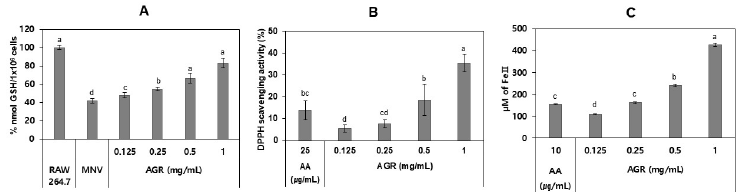
Figure 4. Antioxidant activities of AGR extract. ( A ) GHS levels in MNV-infected cells, ( B ) DPPH radical scavenging activity, and ( C ) FRAP assay. Ascorbic acid (AA) was used as a positive control in DPPH scavenging and FRAP assays. Different letters designate significant differences ( p < 0.05).